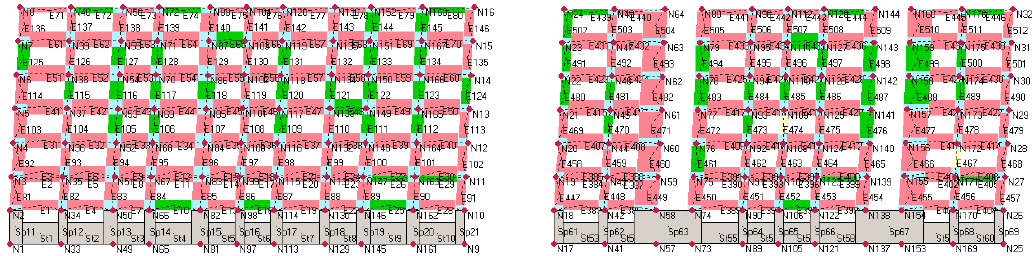
Figure 17. Wall damage after exposure to PGA = 0.1 g—satisfactory behavior of the structure.